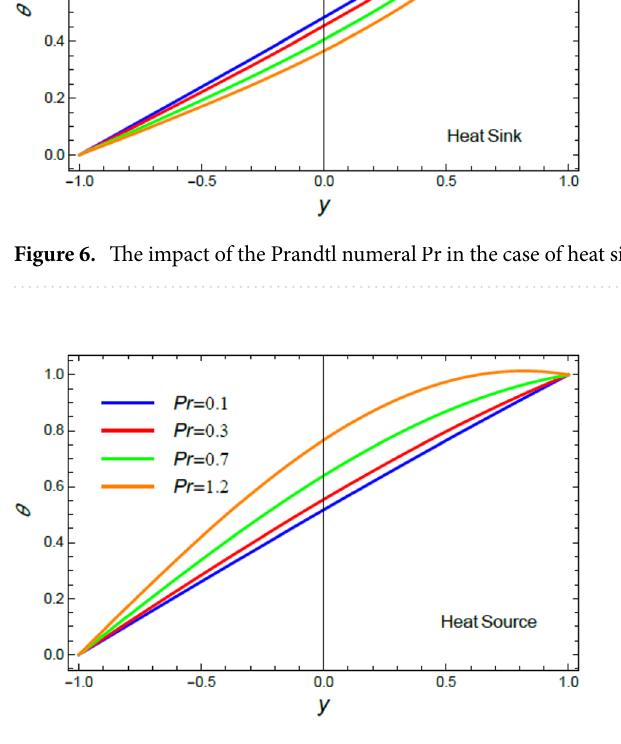
Figure 7. The impact of the Prandtl numeral Pr in the case of heat source on the heat profile θ .